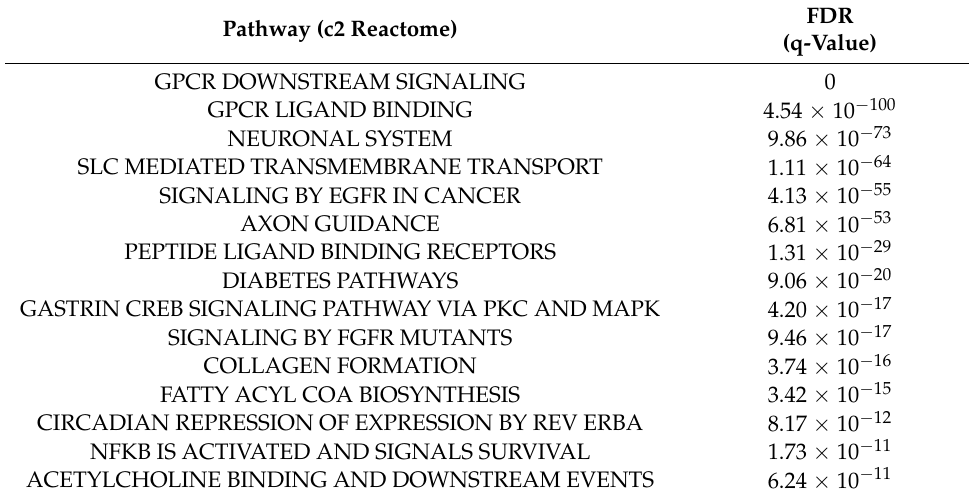
Table 2. Cancer-related c2 reactome; 42 pathways and one sample z-test FDR q-value of pathways (pathways with FDR q-value < 1 × 10 − 10 are shown in this table; the FDR q-values of all 42 pathways are shown in Table